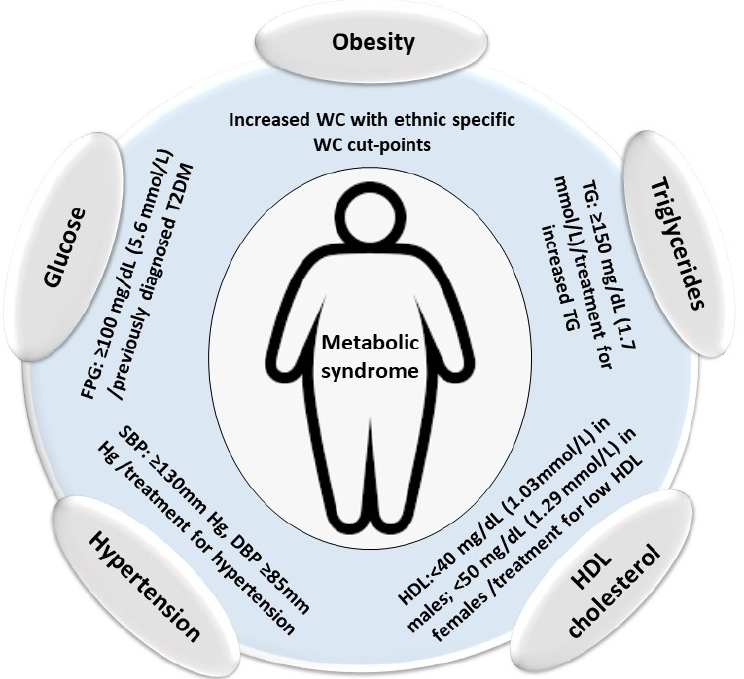
Figure 1. Criteria for the definition of metabolic syndrome. WC: waist circumference, TG: triglycerides, HDL: high-density lipoprotein, SBP: systolic blood pressure, DSP: diastolic blood pressure, FPG: fasting plasma glucose.